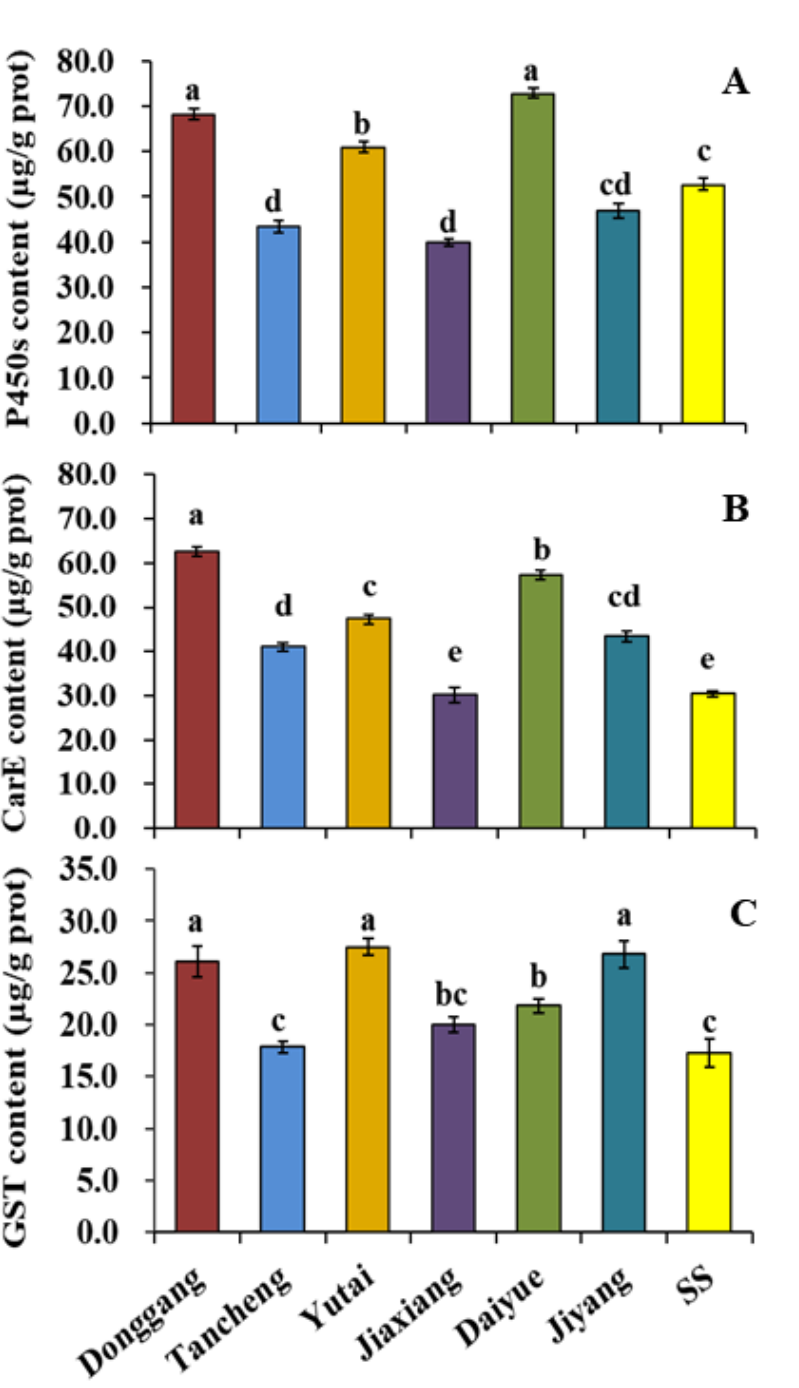
Figure 1. P450s ( A ), CarE ( B ), and GST ( C ) contents of six L. striatellus populations in Shandong Province. The data are the mean ± SE ( n = 3), and different letters on the bars indicate significant differences ( p < 0.05).